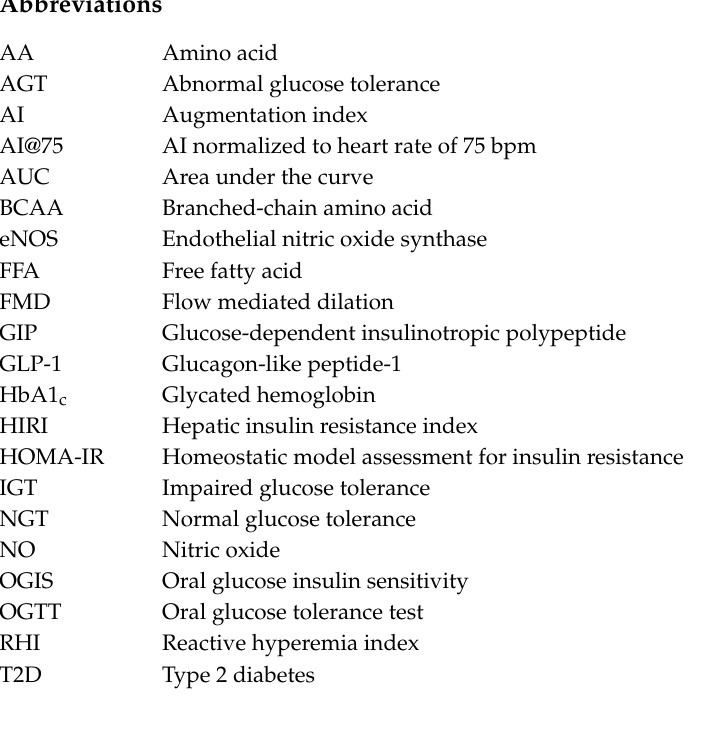
Figure S1: Heart rate and augmentation index normalized to heart rate of 75 bpm